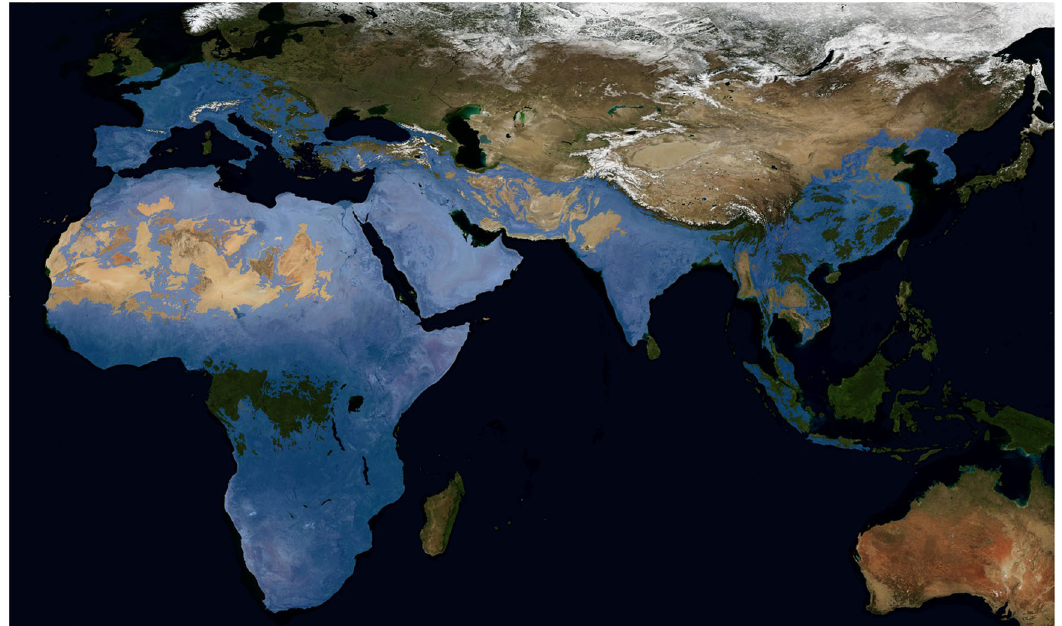
Fig. 1 Distribution of the Acheulean cultural tradition as it is currently understood (marked in blue). Some regions have stronger evidence for the presence of Acheulean technology than others. In some instances this may not re fl ect whether hominins with knowledge of Acheulean technology were present, but instead, re fl ects political and historical differences between regions and their in fl uence on archaeological discoveries. Alternatively, there may be reduced requirements for Acheulean technologies in some of these regions (e.g. the classic Movius line debate [Lycett and Bae, 2010]). In all instances other than central Saharan regions there is archaeological and/or fossil evidence suggesting hominin presence during portions of the Acheulean period, or strong motivation to infer their presence. Original satellite image credit: NASA Visible Earth